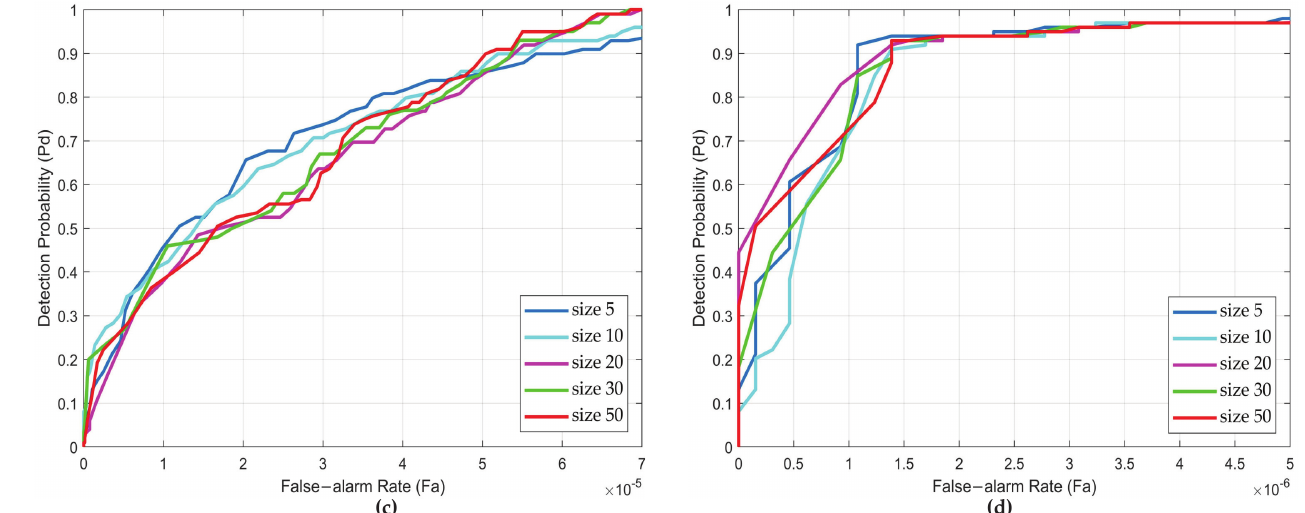
Figure 6. The receiver operating characteristic (ROC) curves of different sizes for four real image sequences. ( a ) Sequence 1. ( b ) Sequence 2. ( c ) Sequence 3. ( d ) Sequence 4.